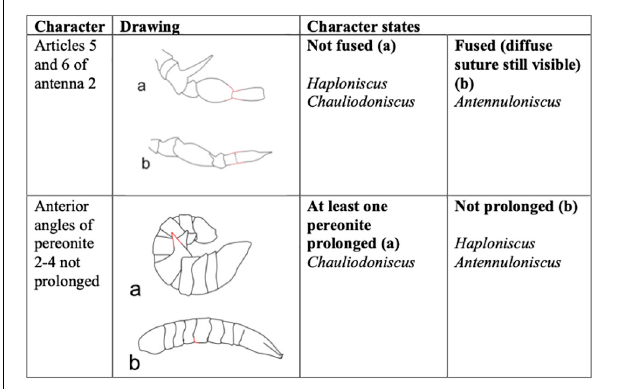
FIGURE 2 | Summary of morphological characters and character states used to create the interactive identification key for genera within Haploniscidae.